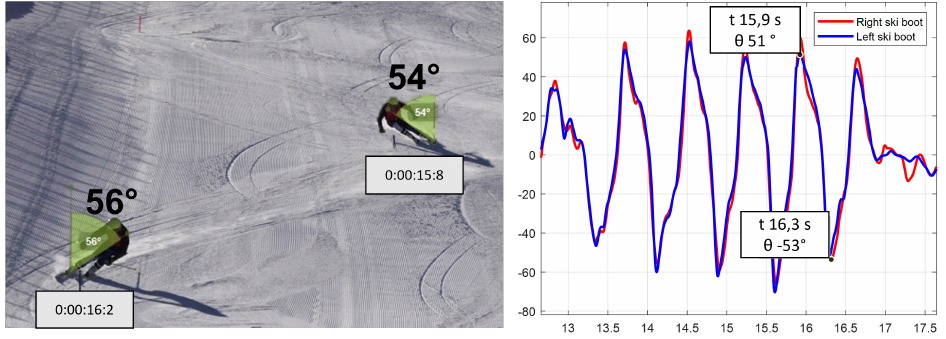
Figure 14. Comparing the video roll angles with the roll angles computed with the